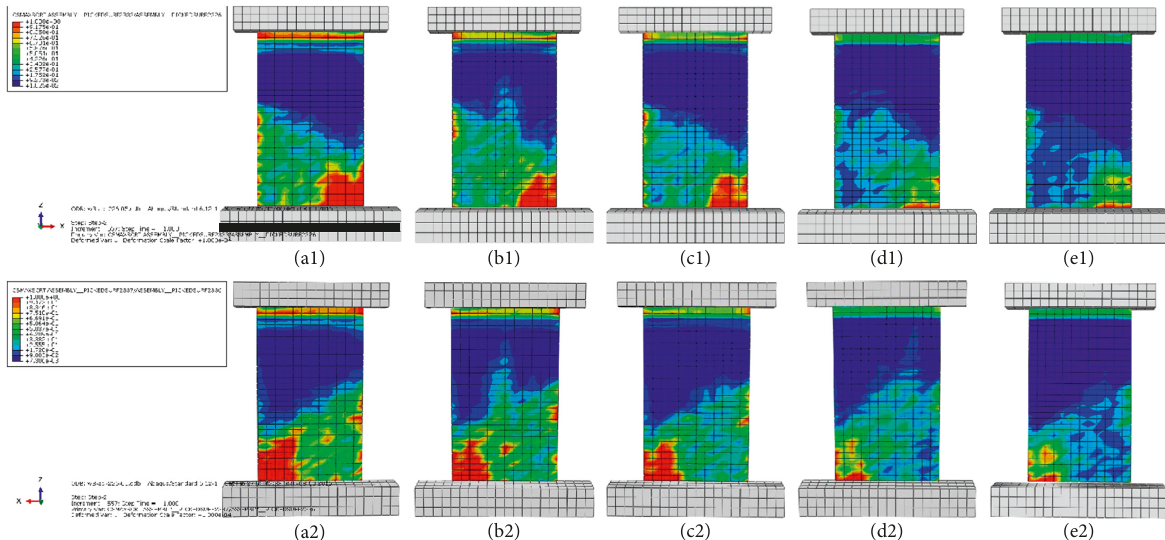
Figure 26: Maximum traction damage initiation criterion index CSMAXSCR of W3 under 0.5 axial compression ratio.